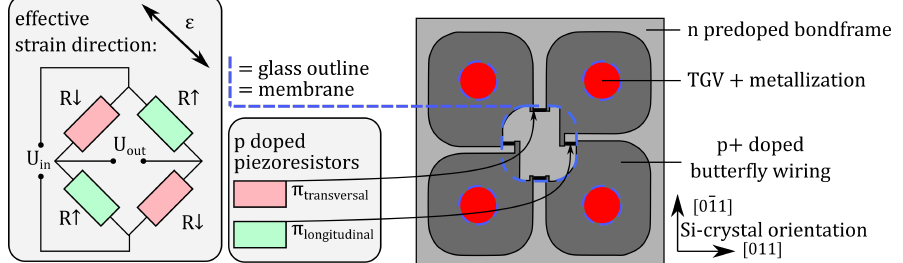
Figure 3. Schematic illustration of the Wheatstone circuit implementation ( left ) and the butterfly wiring scheme ( right